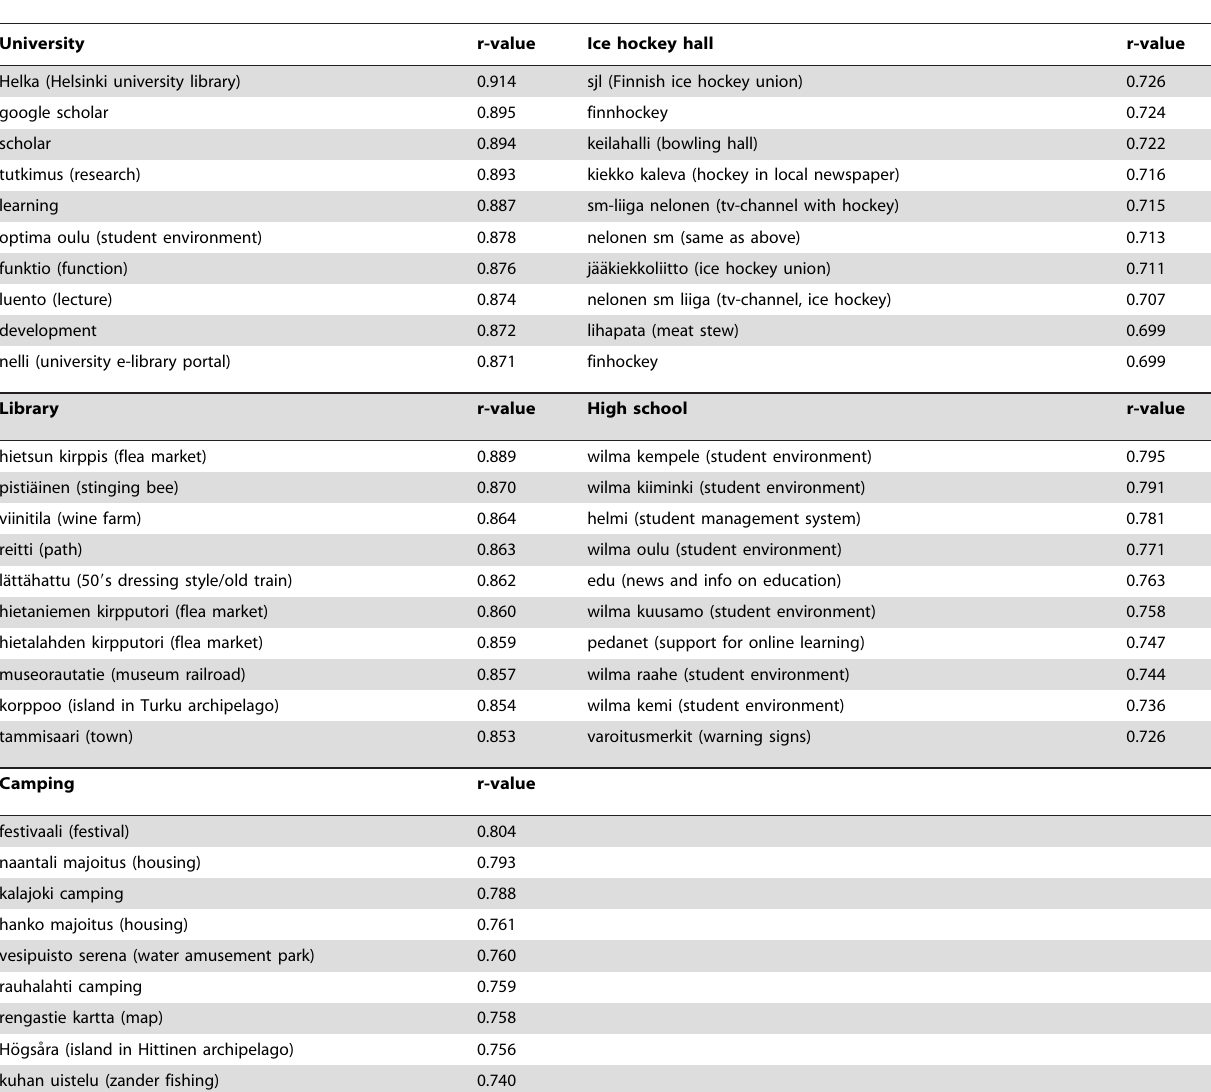
Table 1. Top 10 search engine queries for various